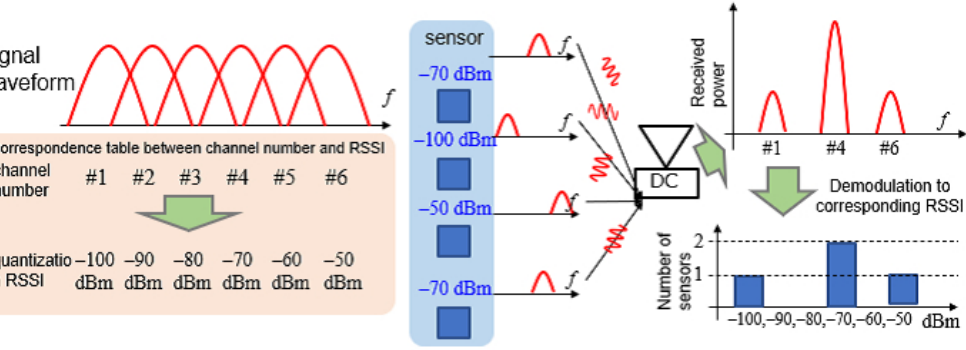
Figure 1. Physical Wireless Parameter Conversion Sensor Networks(PhyC-SNs).